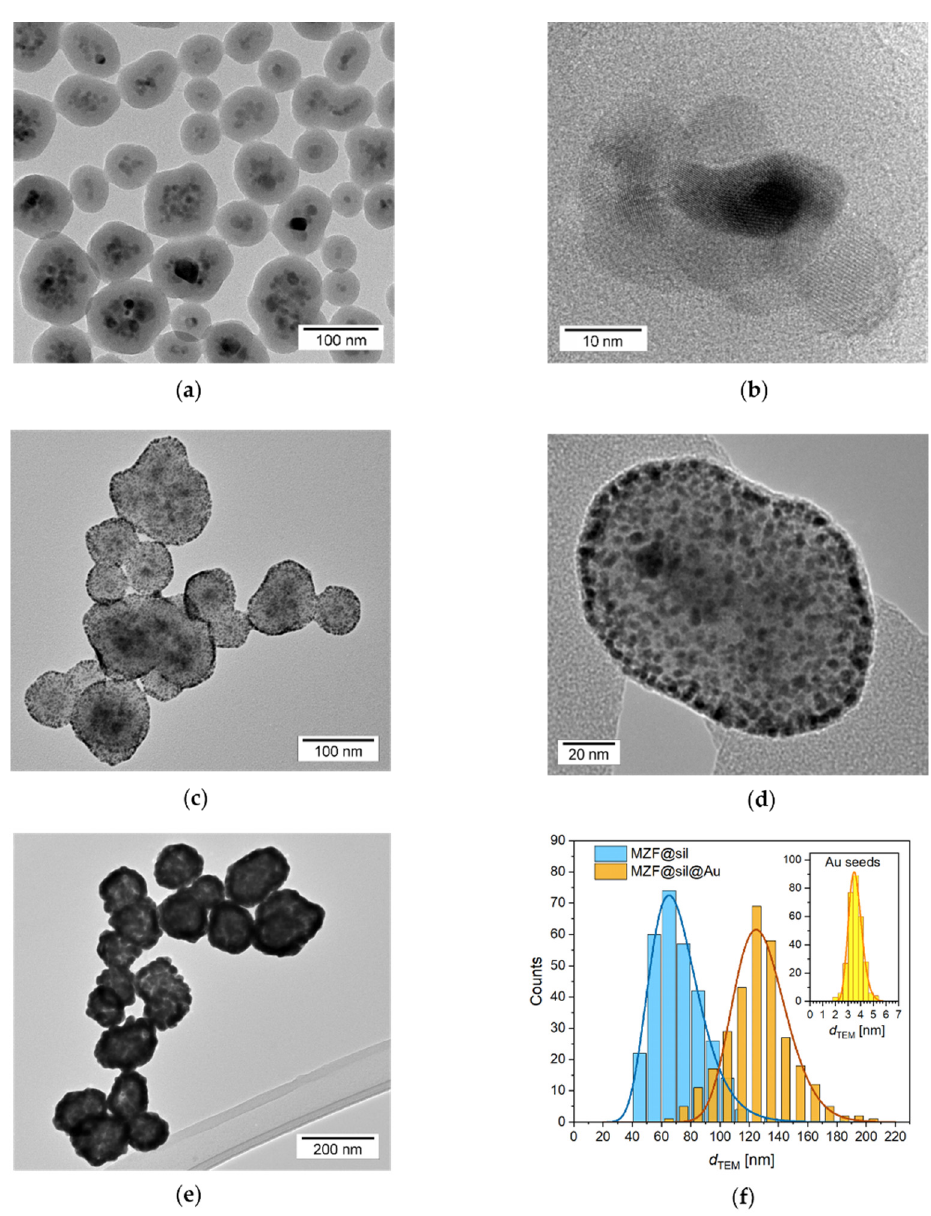
Figure 2. Transmission electron micrographs and size distribution of nanoparticles: ( a ) MZF@sil; ( b ) HRTEM detail of a magnetic core of MZF@sil particles; ( c , d ) MZF@sil nanoparticles decorated with gold seeds; ( e ) MZF@sil@Au; ( f ) histograms of MZF@sil and MZF@sil@Au sizes, with the inset showing the histogram of Au seeds on the surface of the decorated intermediate; the histograms were fitted with a log-normal distribution function.